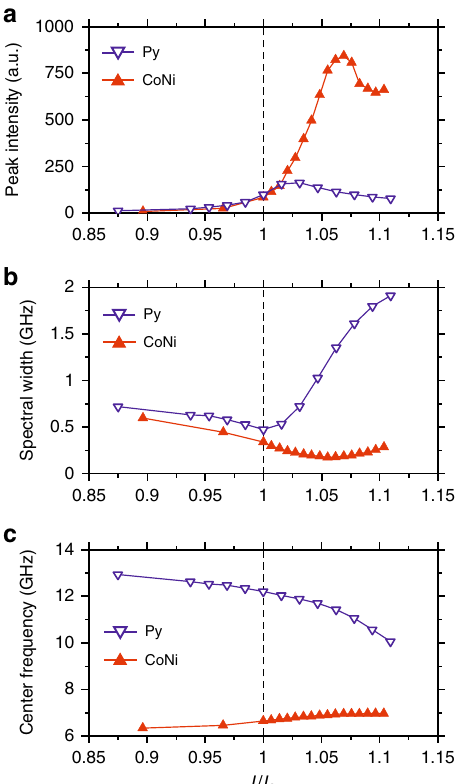
Fig. 2 Characterization of the current-induced magnetization dynamics. a Maximum intensities of the BLS spectra vs current. b Current dependences of the spectral width of the BLS peaks at half the maximum intensity. c Center frequency of the detected spectral peaks vs current. Symbols are the experimental data, lines are guides for the eye. The data were recorded at H 0 = 2.0 kOe